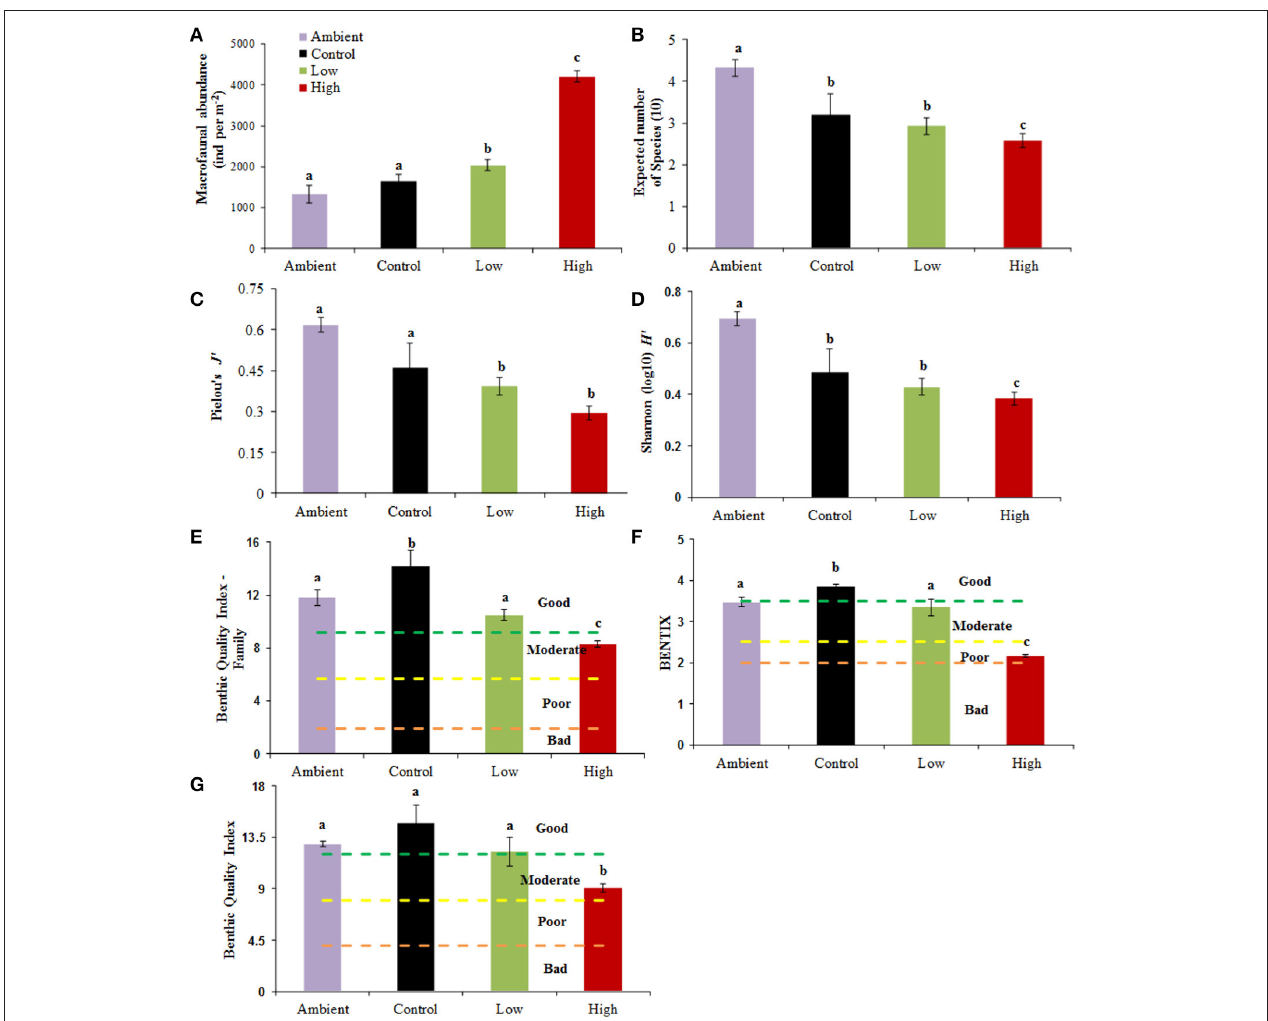
FIGURE 2 | (A-G) Values of diversity indices and Ecological Status indicators calculated from macrofaunal data from each sample. Purple, ambient conditions; Black, Control; Green, Low treatment; Red, High treatment. Dotted lines in Ecological Status indicators indicate the boundaries between the different ES classifications (Bad, Poor, Moderate, Good). Statistically significant differences between groups ( p < 0.05) are indicated by letters “a, b, c,” Data are mean ± SD of three replicates.